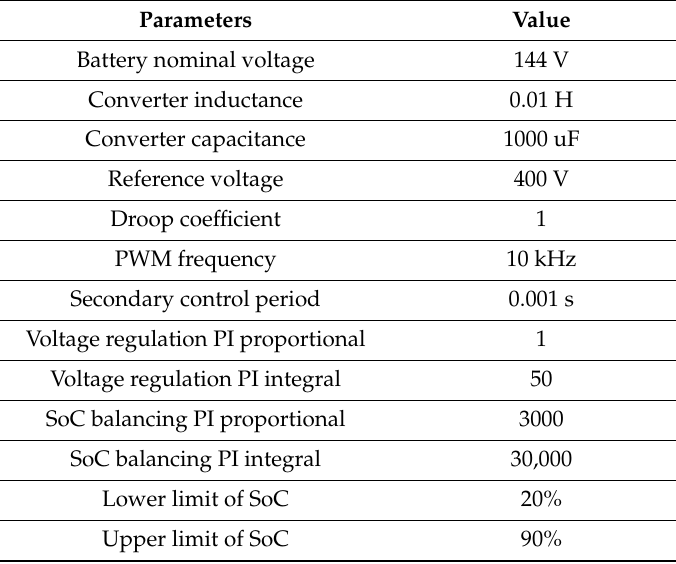
Figure 3. Communication network. Table 1. Public parameters of 8 nodes.